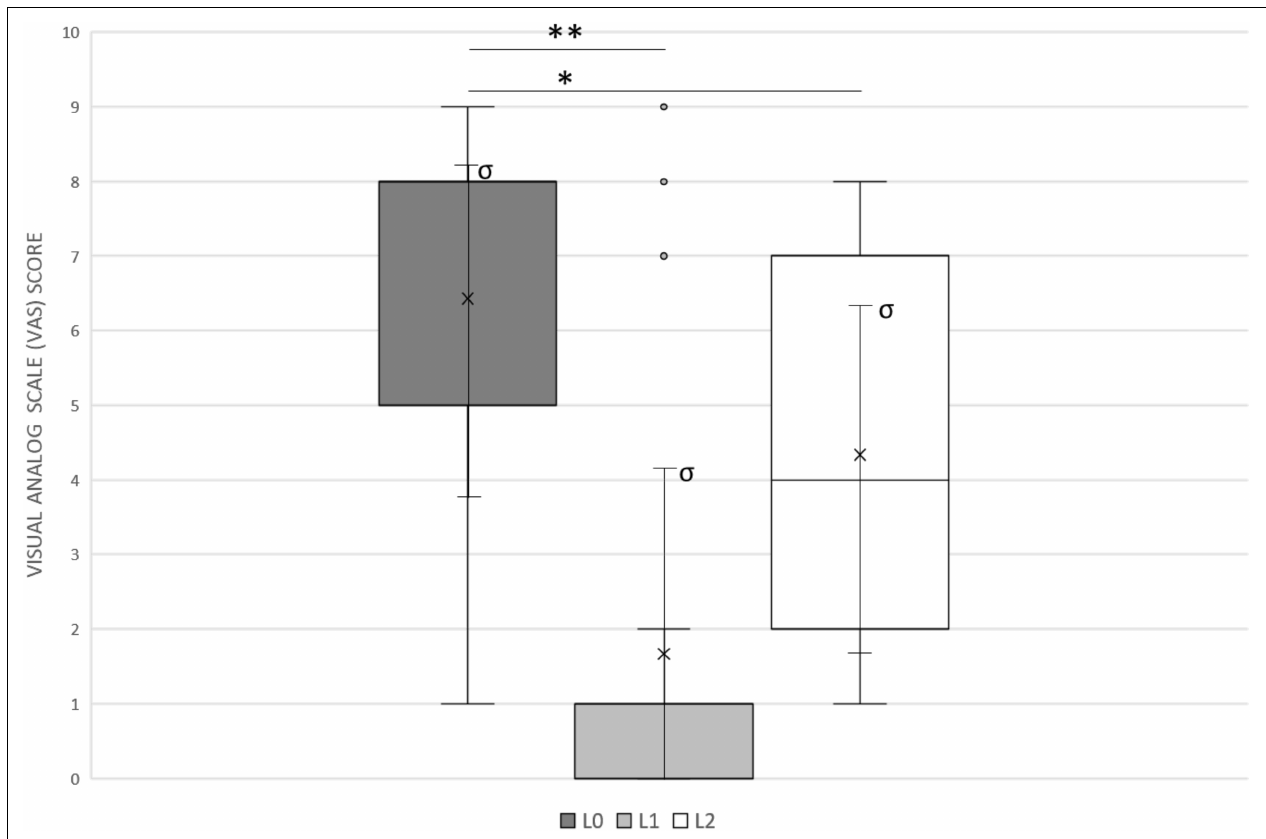
FIGURE 1 | The Visual Analog Scale (VAS) was used to assess tinnitus modification. Patients were asked to rate the perceived loudness of their tinnitus on a numeric scale, from 0 (inaudible) to 10 (loud like never before). L 0 , basal loudness of tinnitus (mean 6.4 ± 2.4); L 1 , minimal loudness of tinnitus at 10 s single-channel stimulation (mean 1.7 ± 2.7); L 2 , loudness of tinnitus after 30 min of whole CI activation (4.3 ± 2.5). Median values are displayed as a horizontal line, mean values as x, standard deviation as σ . We used t -test for statistical analysis. ∗∗ p < 0.01, ∗ p <